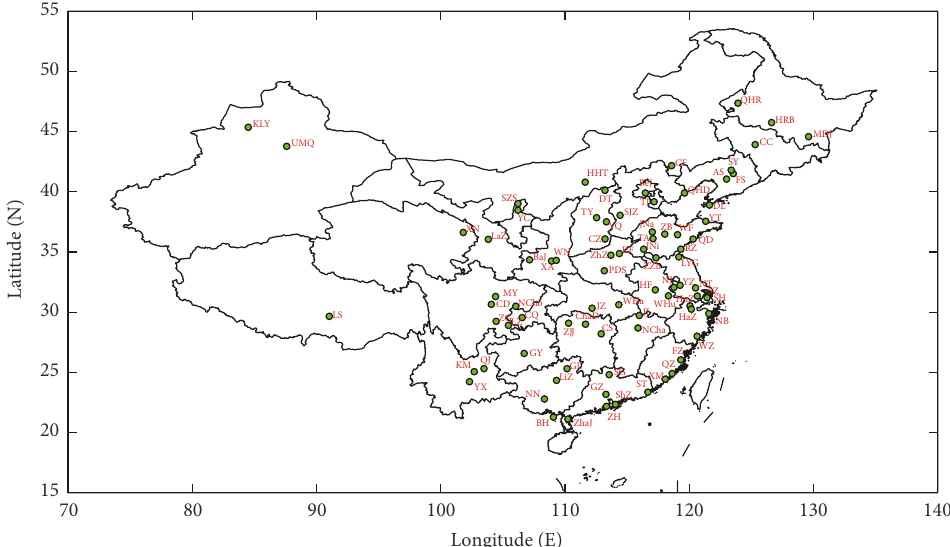
Figure 1: Map of computing area and the observation locations of 74 cities. The green circles denote the 74 cities used in the experiments. Full names of these cities can be found in